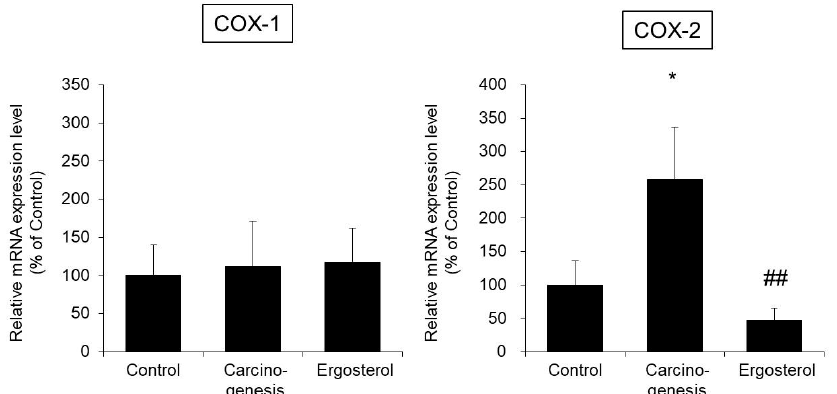
Figure 3. The mRNA expression levels of cyclooxygenase-1 (COX-1) and cyclooxygenase-2 (COX-2) in bladder epithelial cells. The bladders were removed from rats in the control, carcinogenesis, and ergosterol-treated groups, and the mRNA expression levels of COX-1 and COX-2 were measured using real-time RT-PCR and normalized to those of 18S rRNA. The data are presented as percentages of the mean value in the control group, which was set at 100%. The data show the mean ± SD from five rats per group. Tukey’s test, * p < 0.05 vs. the control group, ## p < 0.01 vs. the carcinogenesis group.